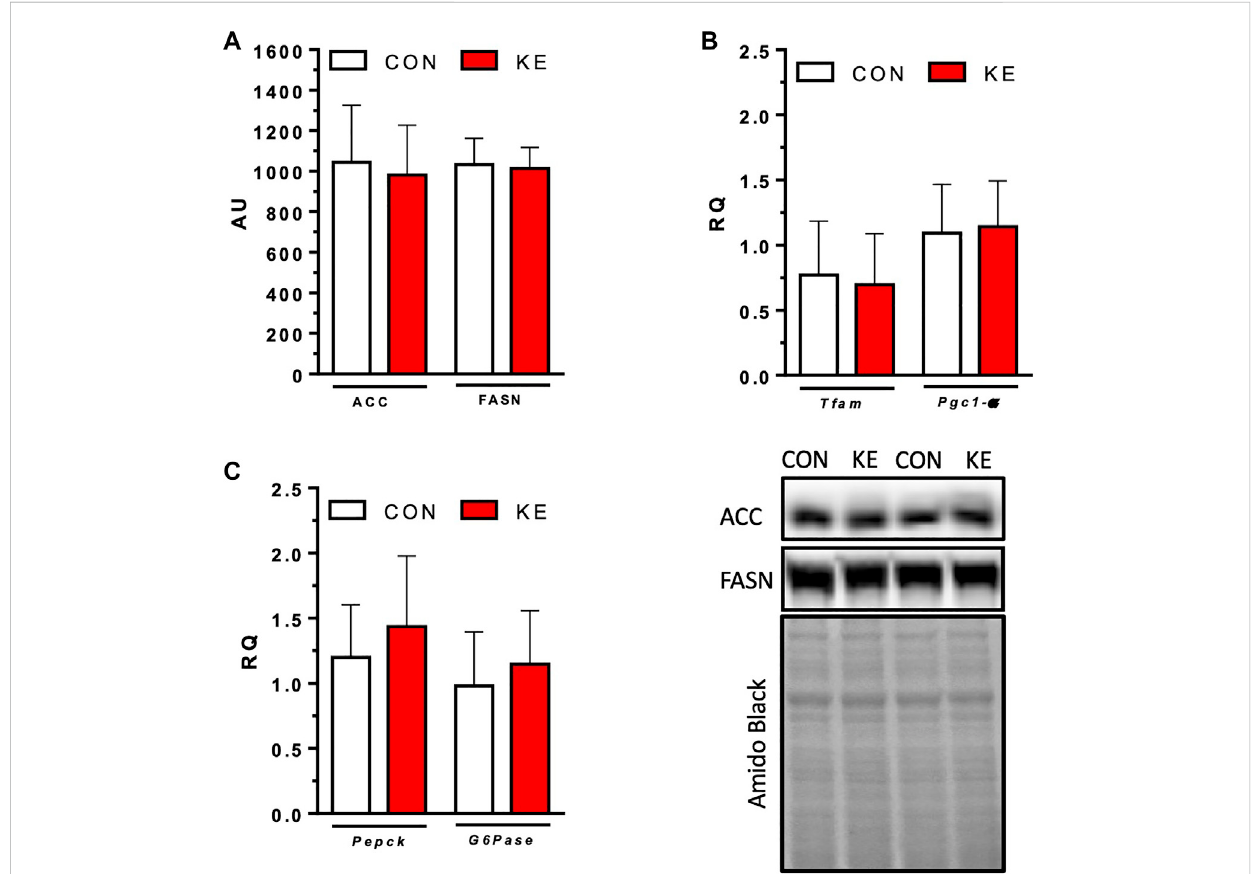
FIGURE 6 Markers of de novo lipogenesis (DNL) and mitochondrial biogenesis. (A) Protein content of hepatic ACC and FASN. (B) mRNA expression of key componentsofDNL, Pgc1- α and Tfam . (C) mRNAexpressionofmarkersofgluconeogenesis ,Pepck and G6pase .Valuesarepresentedasmeans±SD. p < 0.05, * indicates signi fi cant differences between